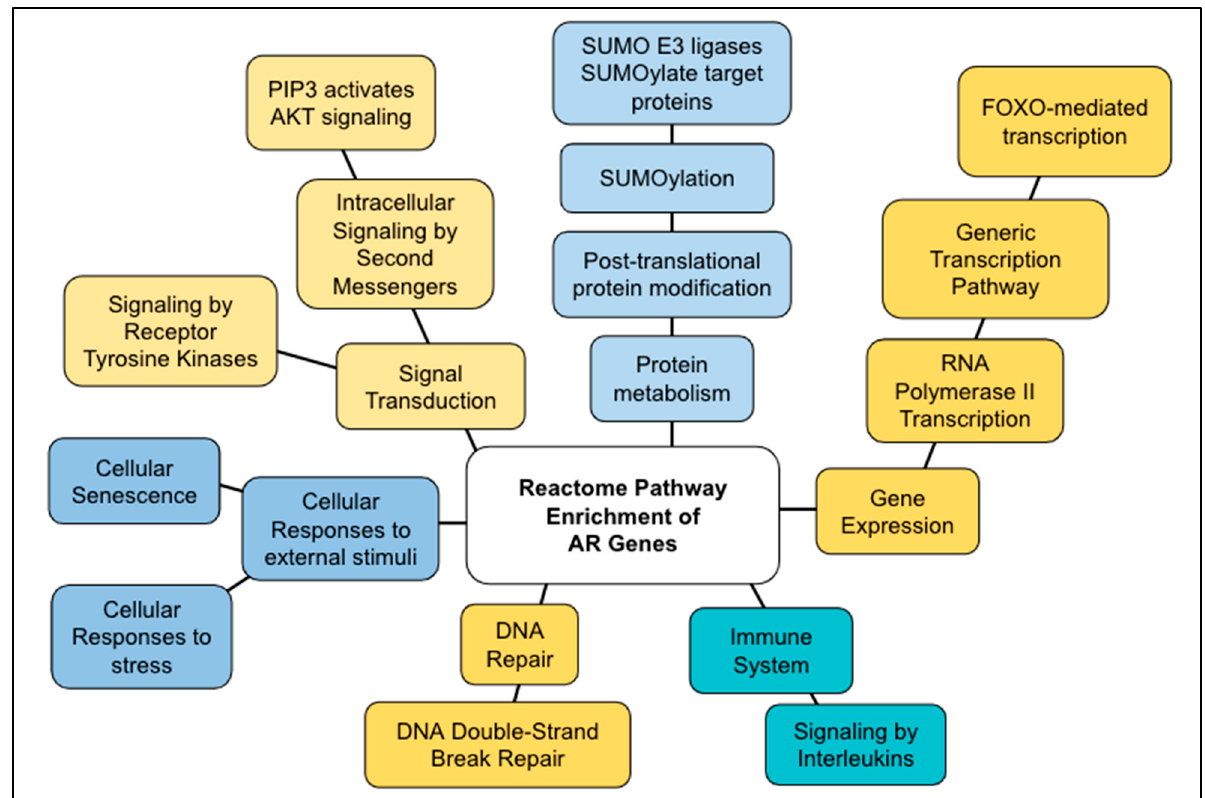
Figure 8. Diagram of the Reactome pathway enrichment of AR genes. The results shown in Table 2 are summarized.